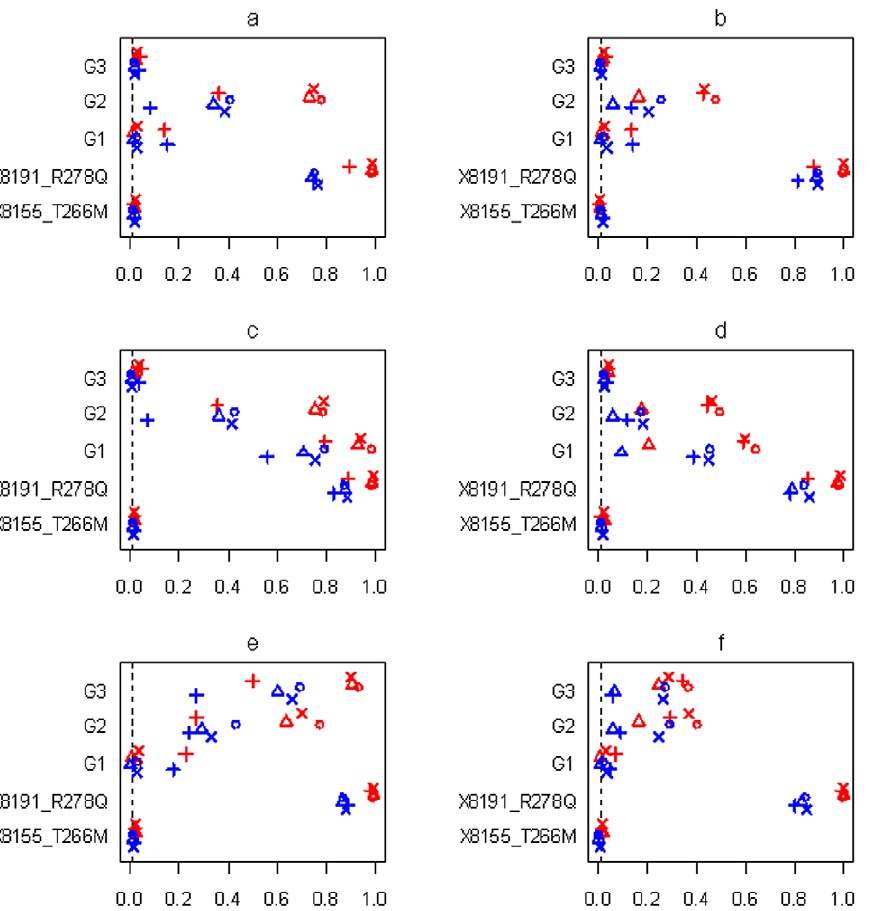
Figure 8. Simulations with sample size n=1,499 and three groups for the six scenarios (see Table 1). Power or Type I error rate for the proposed method ( # ), Yi and Zhi ( 6 ), Simple-Sum ( D ) and All-Variants ( + ) under the threshold level of 0.01. X8155_T266M and X8191_R278Q are the two common non-synonymous variants, and G1, G2 and G3 are the three group effects (G1: common synonymous; G2: rare non-synonymous; G3: rare synonymous). Red and blue symbols represent results for continuous and binary traits, respectively. The dashed line is the nominal 0.01 level.